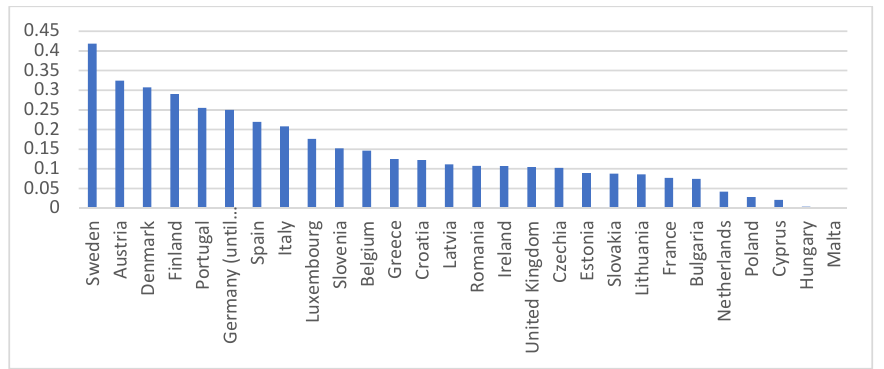
Figure 2. Development taxonomic ratio values (RMT) for the examined countries in 2009. Source: author’s own elaboration.